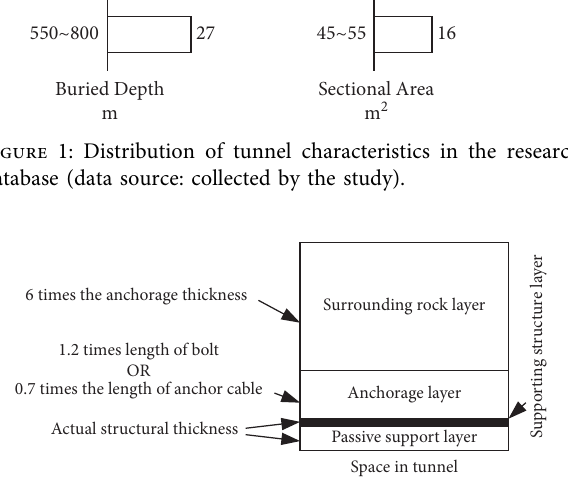
Figure 2: Design principle of the finite element three-dimensional model (local of roof